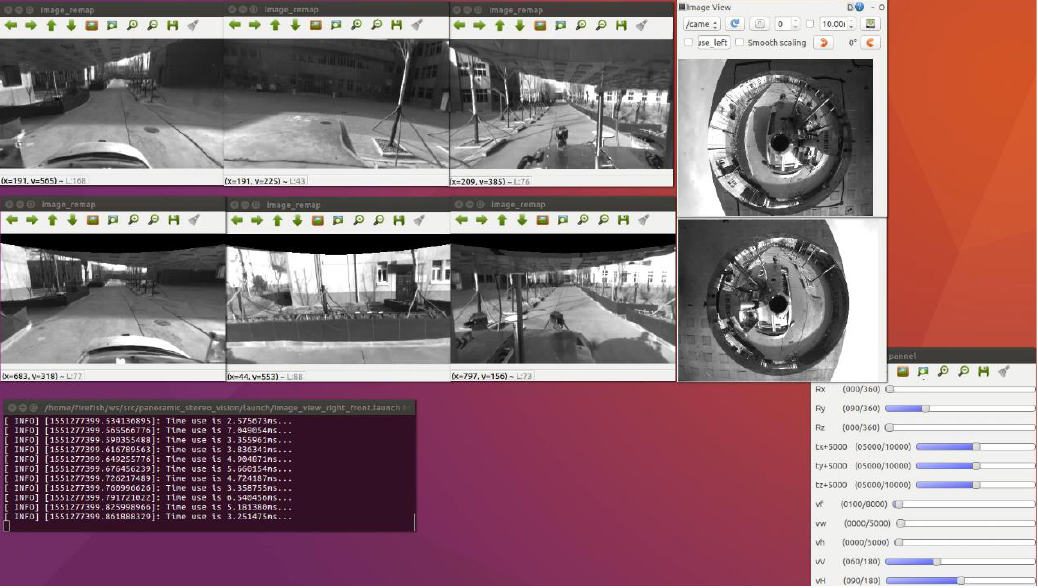
Figure 30. Six -d irection real-time deployment rendering. Figure 30. Six-direction real-time deployment